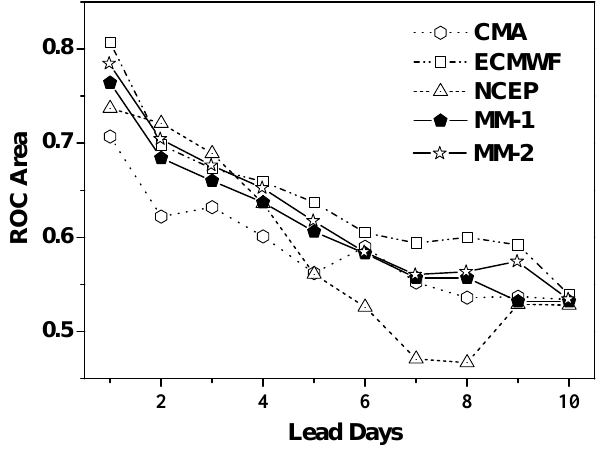
Fig. 3. Variation of ROC areas as forecast lead days ranging from 1 to 10